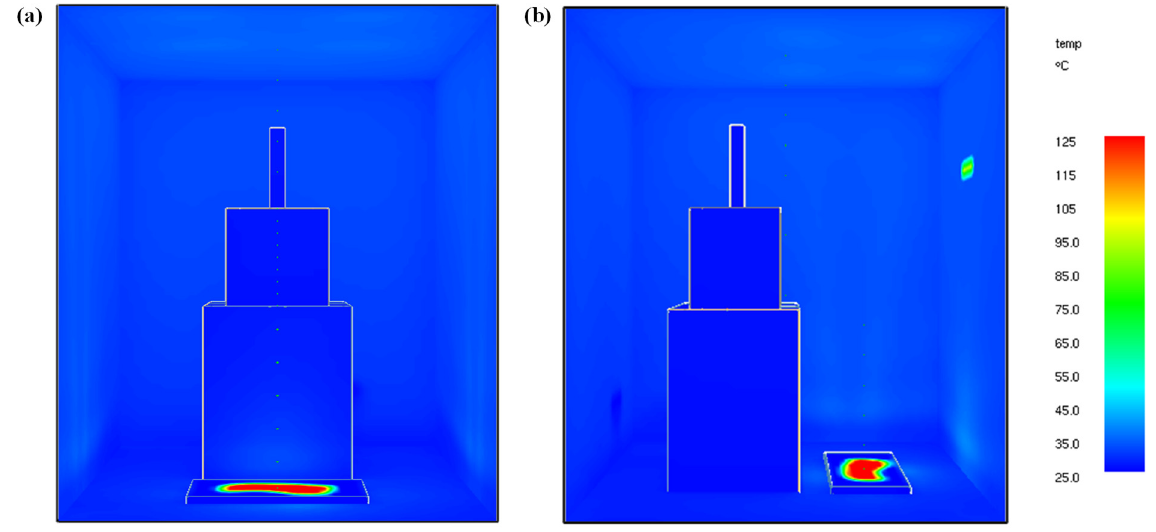
Figure 11. The temperature profile of the cleaning system and enclosure ( a ) from the fire facing side ( b ) front view fire facing side after 500 s.